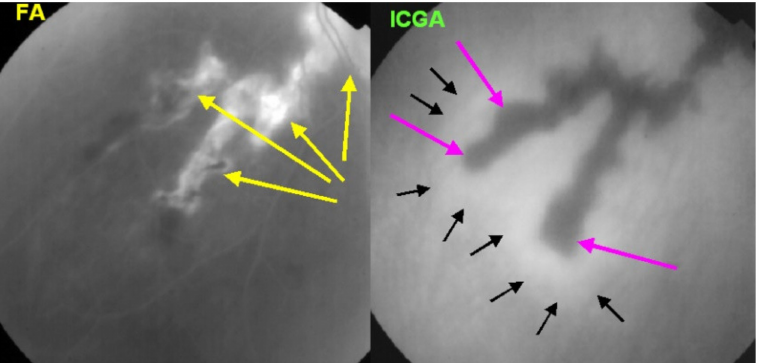
Figure 24. SC: comparison of FA and ICGA features in progressing disease. FA ( left ) shows hyperflu- orescent areas resulting from window effect produced by atrophic chorioretinal areas (yellow arrows). ICGA ( right ) shows that atrophy ± active areas of disease is far more extended than supposed on FA (crimson arrows). Moreover, ICGA shows perilesional hyperfluorescence, indicating the progression of lesions (black arrows). Yellow arrows on FA show occult active areas revealed by